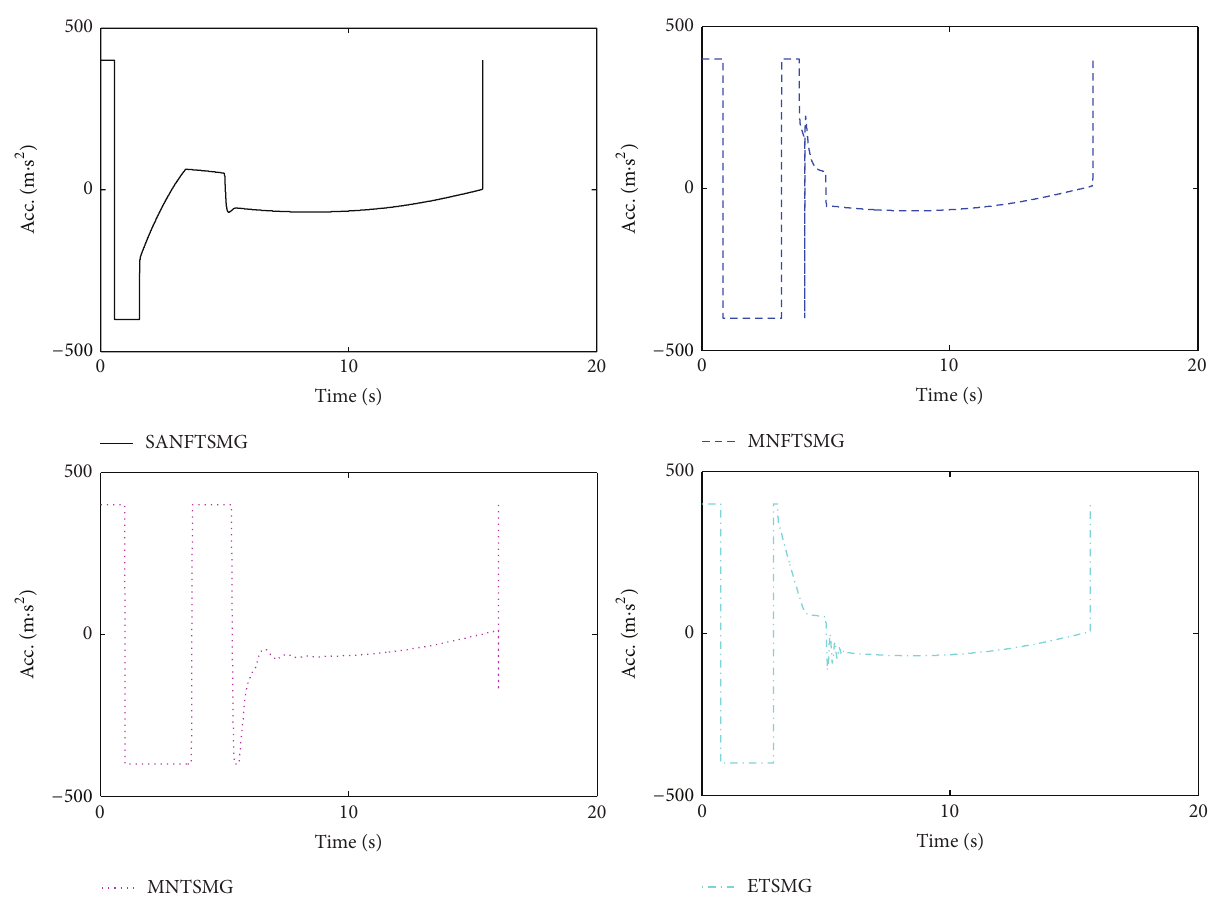
Figure 27: Trajectories of missile and target (Case 2).